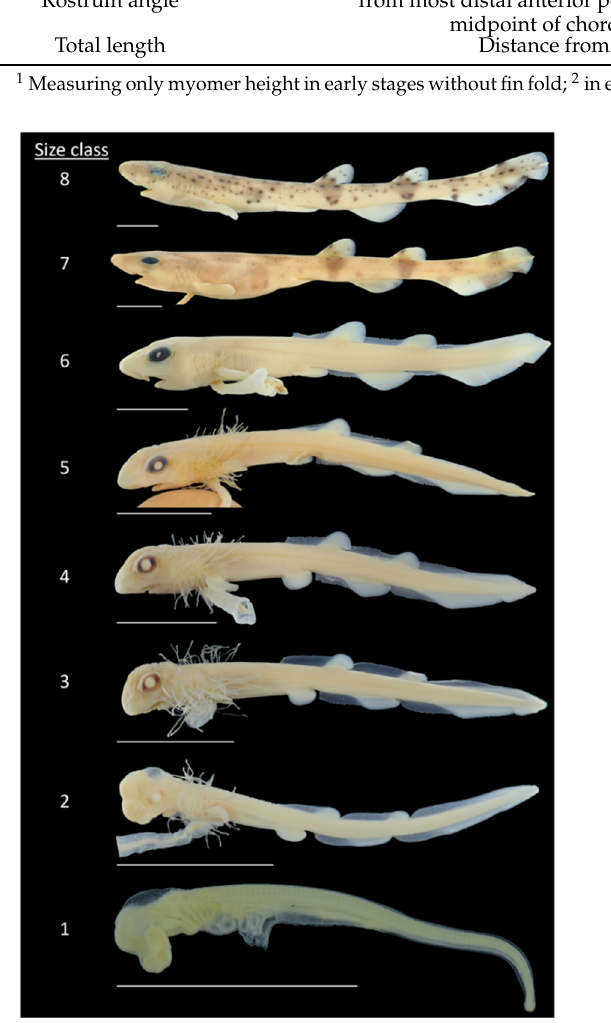
Figure 2. Small-spotted catshark ( Scyliorhinus canicula ). Embryos at different developmental stages and size classes from early development (Size Class 1) to late embryonic stage (Size Class 8) shortly before hatching. Scale 1 cm. Table 2. Overview of examined developmental stages and size classes of S cyliorhinus canicula .